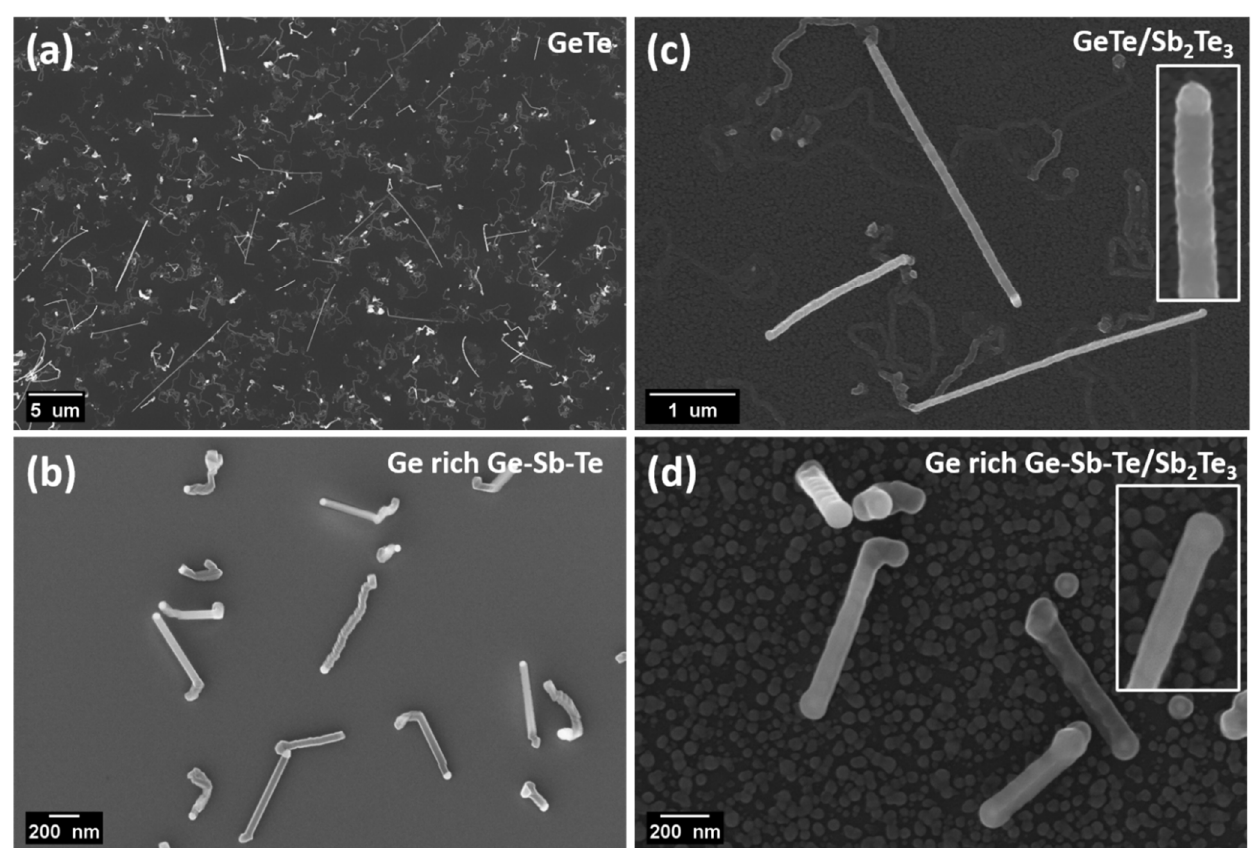
Figure 1. Top-view SEM image of ( a ) GT, ( b ) GGST core; and ( c ) GT/ST, ( d ) GGST/ST core-shell NWs with 10 nm shell thickness, insets show the magnified view of a single NW. NWs with 10 nm shell thickness, insets show the magnified view of a single